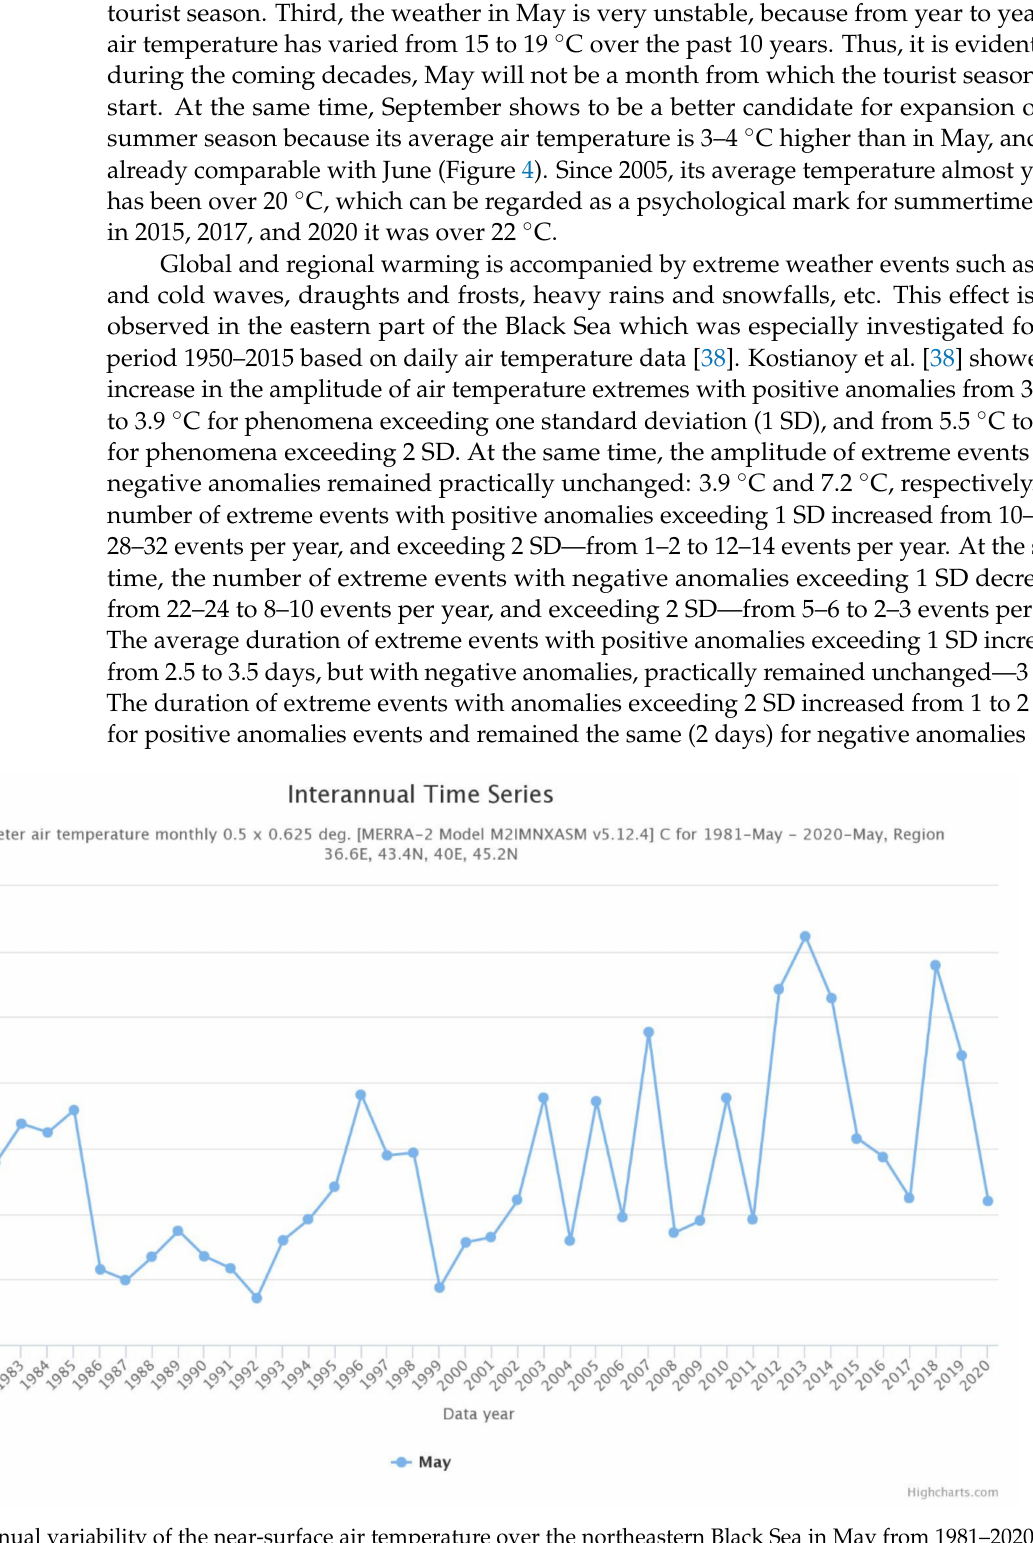
Figure 3. Interannual variability of the near-surface air temperature over the northeastern Black Sea in May from 1981–2020 based on the MERRA-2 M2IMNXASM_5.12.4